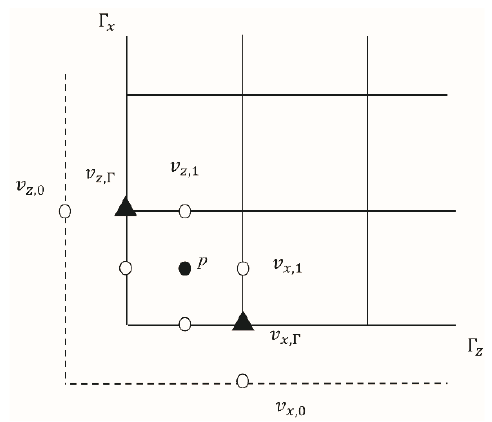
Figure 2. Projection formulation of the Marker-and-Cell (MAC) scheme.